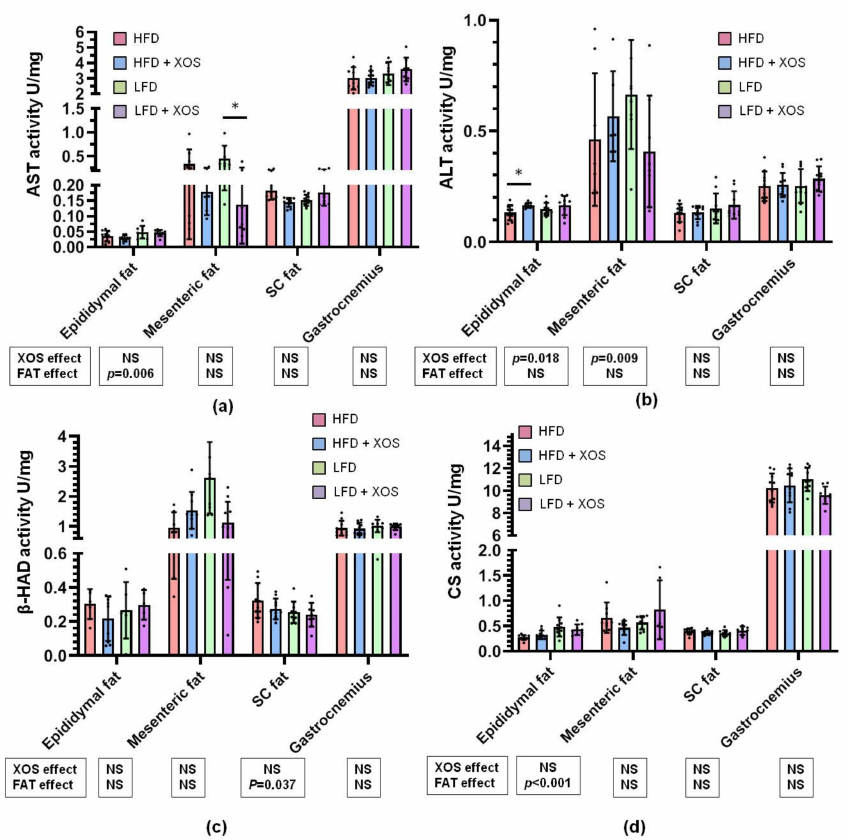
Figure 6. The activities of ( a ) AST, ( b ) ALT, ( c ) β -HAD and ( d ) CS in epididymal, mesenteric and subcutaneous (SC) adipose tissue as well as gastrocnemius muscle. * indicates statistically significant ( p < 0.05) difference between the HFD or LFD group and the corresponding XOS-supplemented group as determined by Mann Whitney U